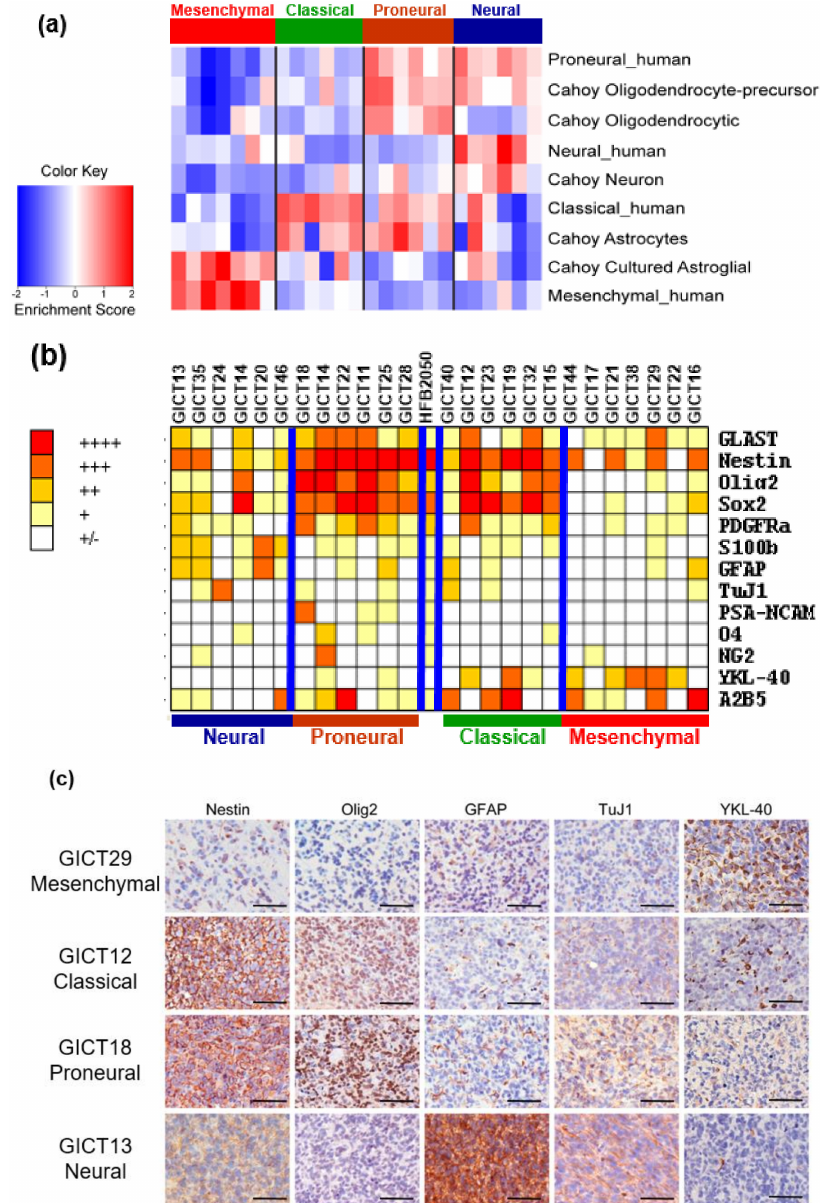
Figure 2. ( a ) GIC subtypes di ff erentially expressed lineage markers for neural stem / progenitor cells (neuroepithelial cells, radial glia, glial progenitors, neuronal progenitors, oligodendrocyte progenitor cells, and SVZ astrocytes). ( b ) GIC subtypes exhibited distinct lineage profiles that recapitulated neural development. Earlier lineage markers (Nestin, Sox2, Olig2) are highly expressed in proneural and classical GICs, while di ff erentiation markers (GFAP: glial fibrillary acidic protein, TuJ1: Neuron-specific beta-III Tubulin) are abundant in neural GICs. YKL-40: Chitinase-3-like protein 1 is enriched in mesenchymal GICs. ( c ): Lineage characteristics of GIC subtypes are retained in their intracranial xenografts. One of representative results of each subtypes are illustrated in Figure 2C. Scale bars: 100 µ